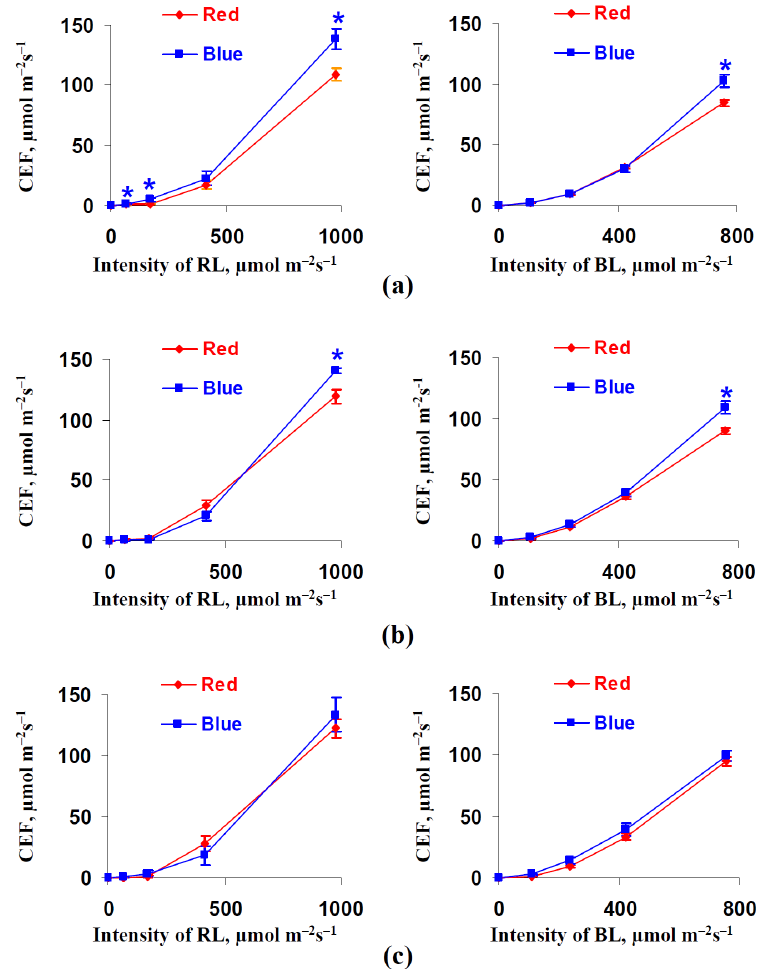
Figure 7. Dependences of the cyclic electron flow around photosystem I (CEF) on the intensity of the red actinic light (RL) (left panels) and blue actinic light (BL) (right panels) after 18 ( a ), 25 ( b ), and 32 ( c ) days of lettuce cultivation under the red (marked as “Red”) and blue (marked as “Blue”) illumination variants (see Figure 1) ( n = 5–7). * differences between plants cultivated under the red and blue illumination variants were significant ( p < 0.05).